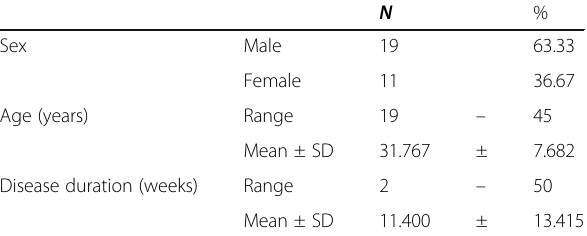
Table 1 Demographic data of patients Table 2 Comparison between US grading score before